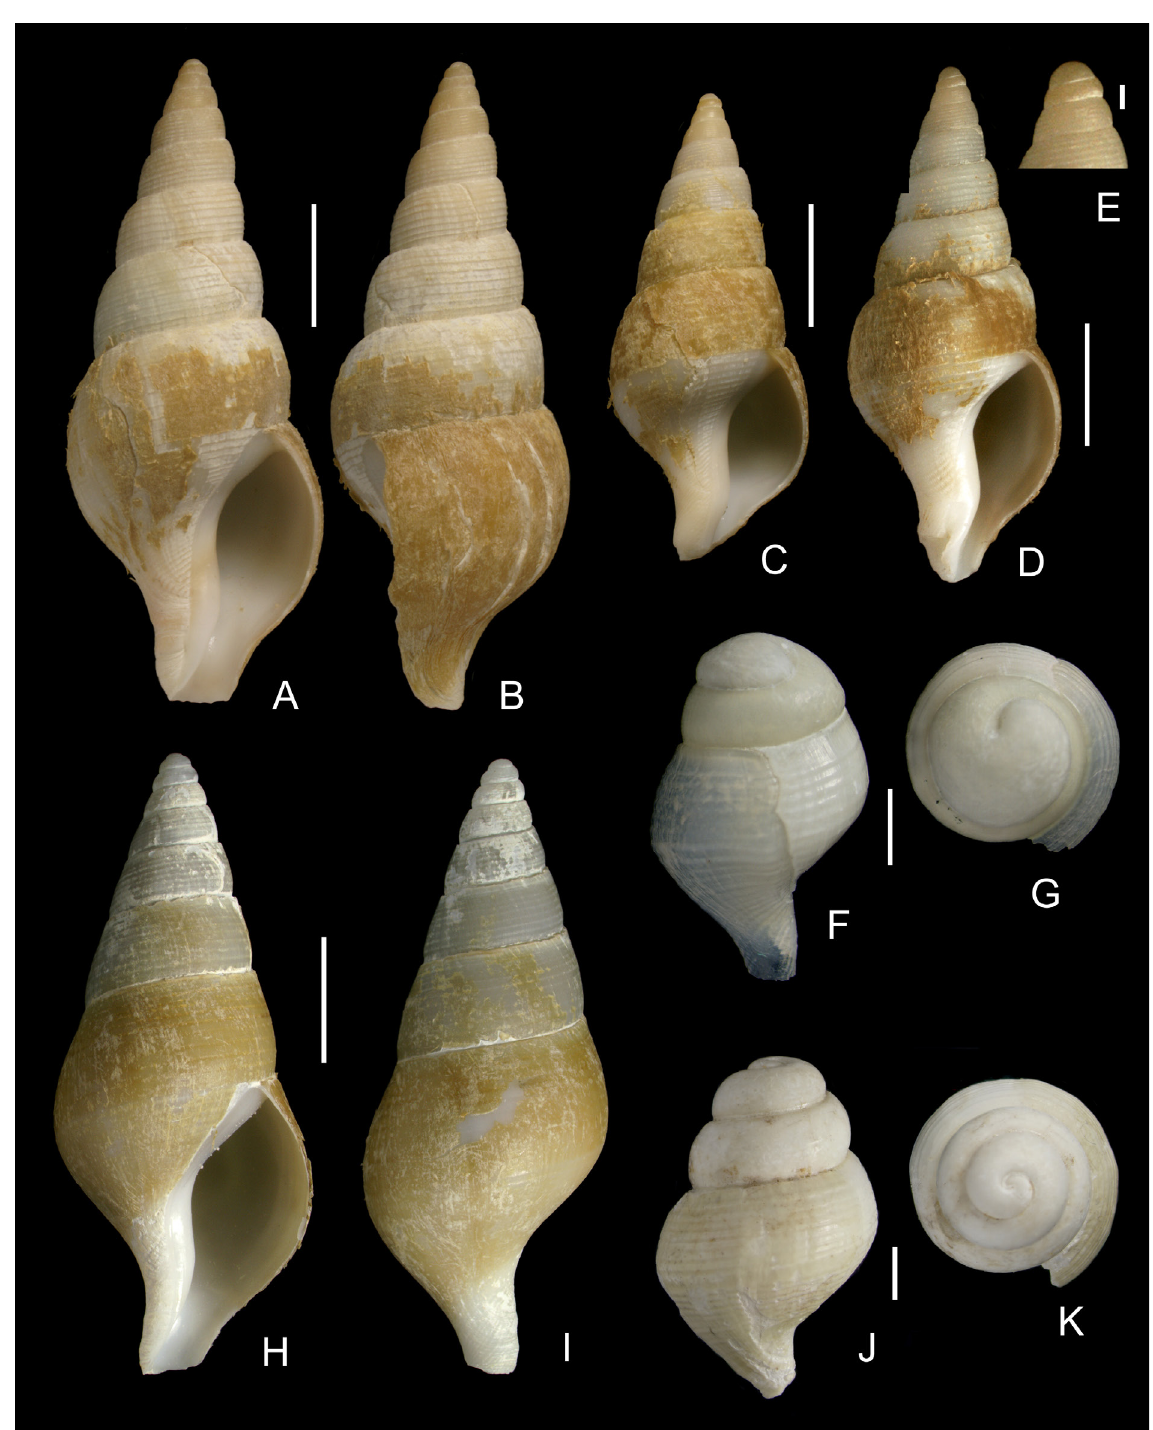
Fig. 24. Colidae. A–D . Colus gracilis (da Costa, 1778), ECOMARG 0709, R2, 615 m, 52 mm, 38 mm and 42 mm. E . Detail of apical whorls, same specimen as D. F–G . C. gracilis , juvenile shell with protoconch and half teleoconch whorl, BANGAL 0711, V4, 744 m, 4.5 mm. H–I . Colus jeffreysianus (P. Fischer, 1868), BANGAL 0711, V10, 1720 m, 49.3 mm. J–K . C. jeffreysianus , juvenile shell with protoconch and half teleoconch whorl, 6.5 mm, from the same locality. Scale bars: A–D, H–I = 10 mm; E–G, J–K = 1